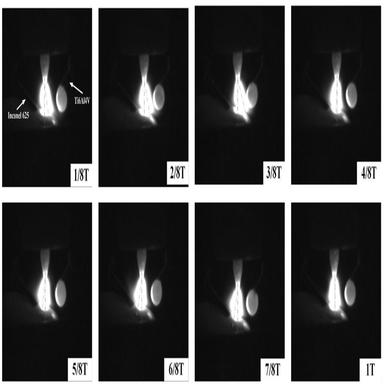
Arc swing pattern for one cycle.